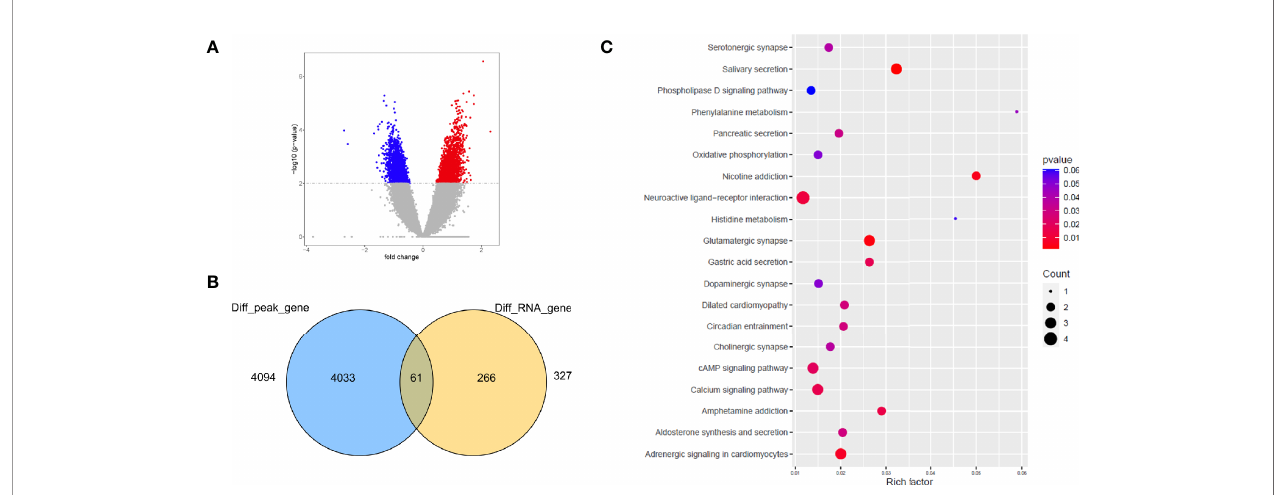
FIGURE 4 | Integrative analysis of open chromatin peaks with DEGs detected by RNA-seq. (A) Volcano plot shows the ATAC-seq peaks speci fi c to the ES (blue) and LS (red) samples. (B) Venn diagram showing the number of differentially abundant ATAC-seq peak-associated genes and DEGs. (C) KEGG pathway enrichment analysis of the overlapping genes of ATAC-seq and RNA-seq.